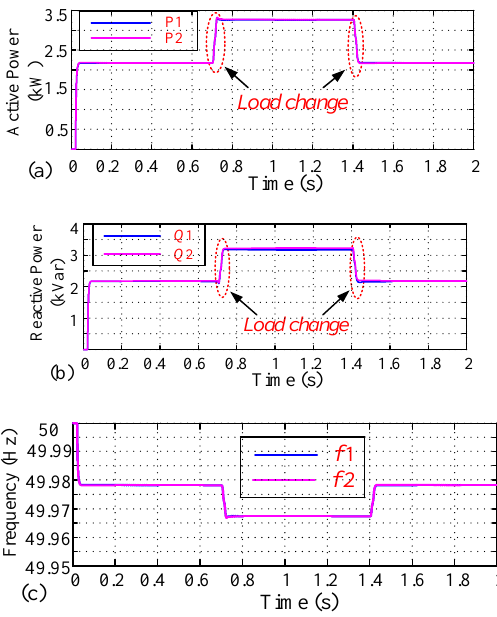
Figure 8. Simulation results in Case B: ( a ) active power; ( b ) reactive power; and ( c ) frequency. 6.3. Case C: Both Power Rating of DG1 Are Twice Those of DG2 under Resistance-Inductance Load In this case, to verify the proportionate power sharing of both DGs, the P -ω droop gain m and Q - V droop gain n are chose according to Equations (31) and (32) as shown in Table 2.